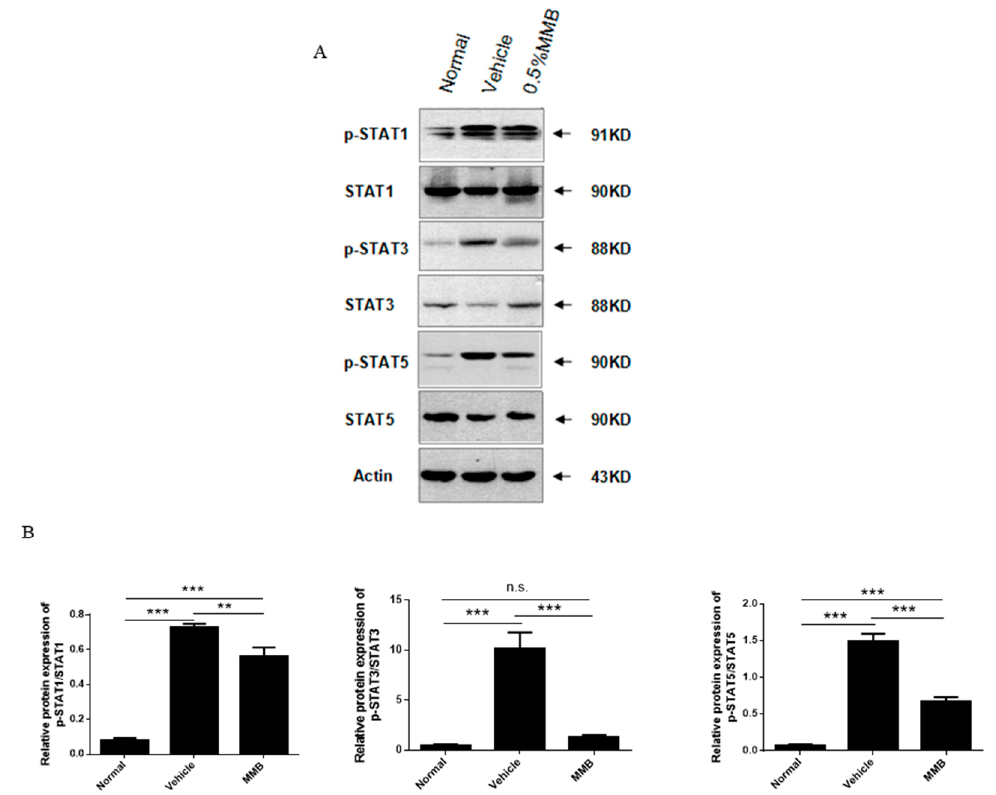
Figure 5. The protein levels of p-STAT1; p-STAT3; p-STAT5; and STAT-1, STAT-3, and STAT5 in normal, vehicle, and 0.5% MMB groups, respectively. ( A ) Western blot and ( B ) quantitative analysis of dot intensity. Actin was used as a reference protein. Values are mean ± SD ( n = 3). * * p < 0.01, *** p < 0.001, n.s.: no statistical significance.